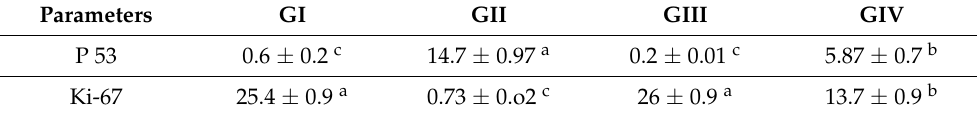
Table 4. Quantitative analysis of immunohistochemical parameters P 53 and Ki-67 in testicular tissue. Parameters